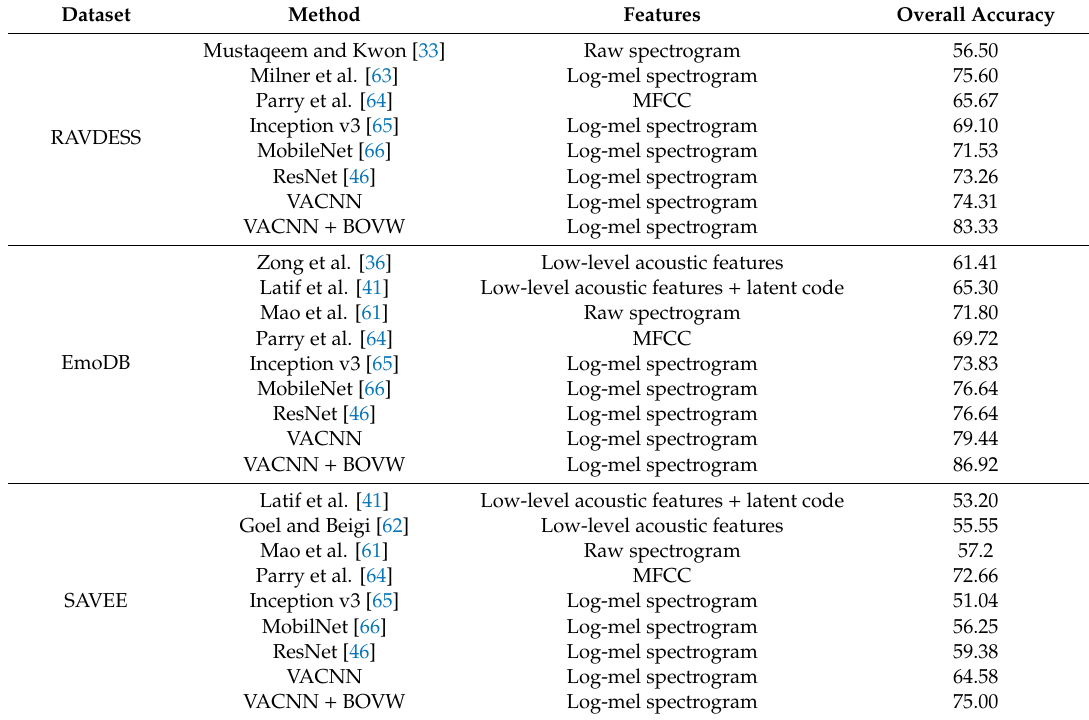
Comparison of our method and related works on RAVDESS, EmoDB, SAVEE for cross-corpus